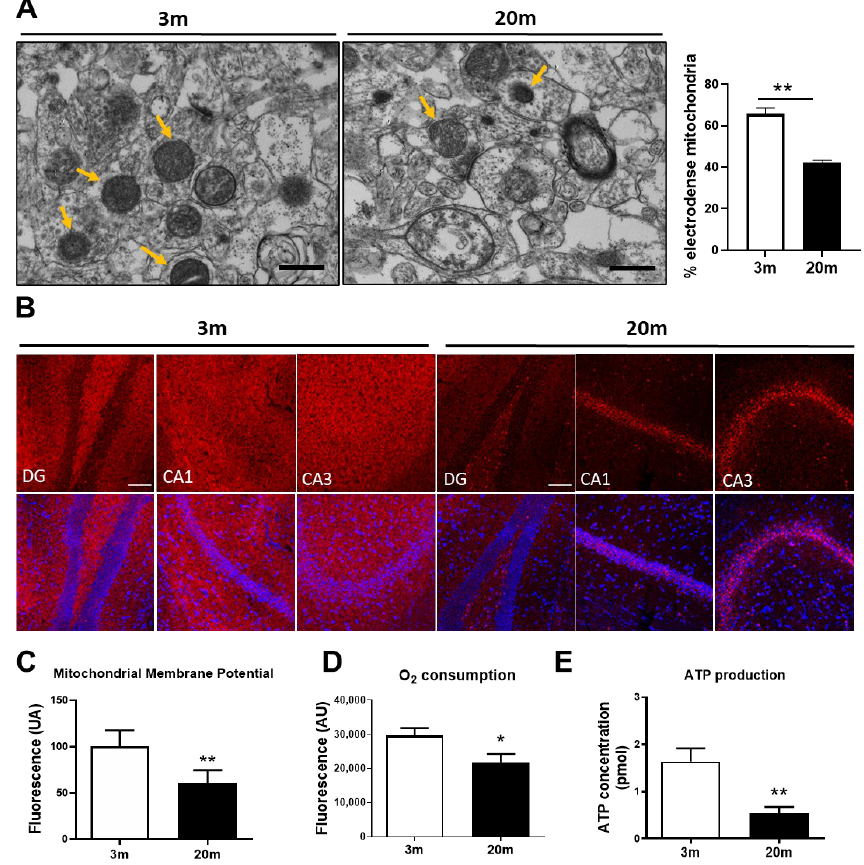
Figure 1. Hippocampal aging reduces energy production and metabolic power of mitochondria in female C57BL/6J mice. ( A ) Representative transmission electron microscopy (TEM) images of the hippocampal CA1 region of 3 mo and 20 mo mice with its quantification indicating the percentage